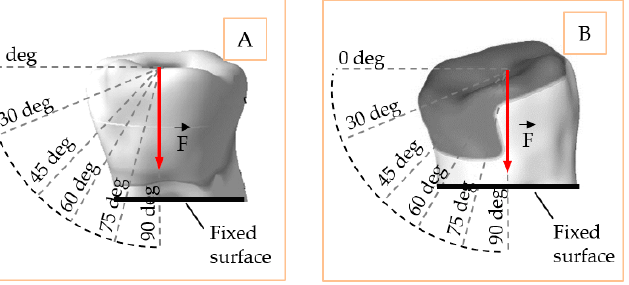
Figure 4. Loading and restraining conditions of the inlay model ( A ) and onlay model ( B ).